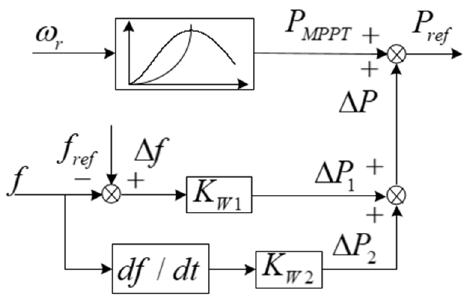
Figure 1. Block diagram of comprehensive inertial control.